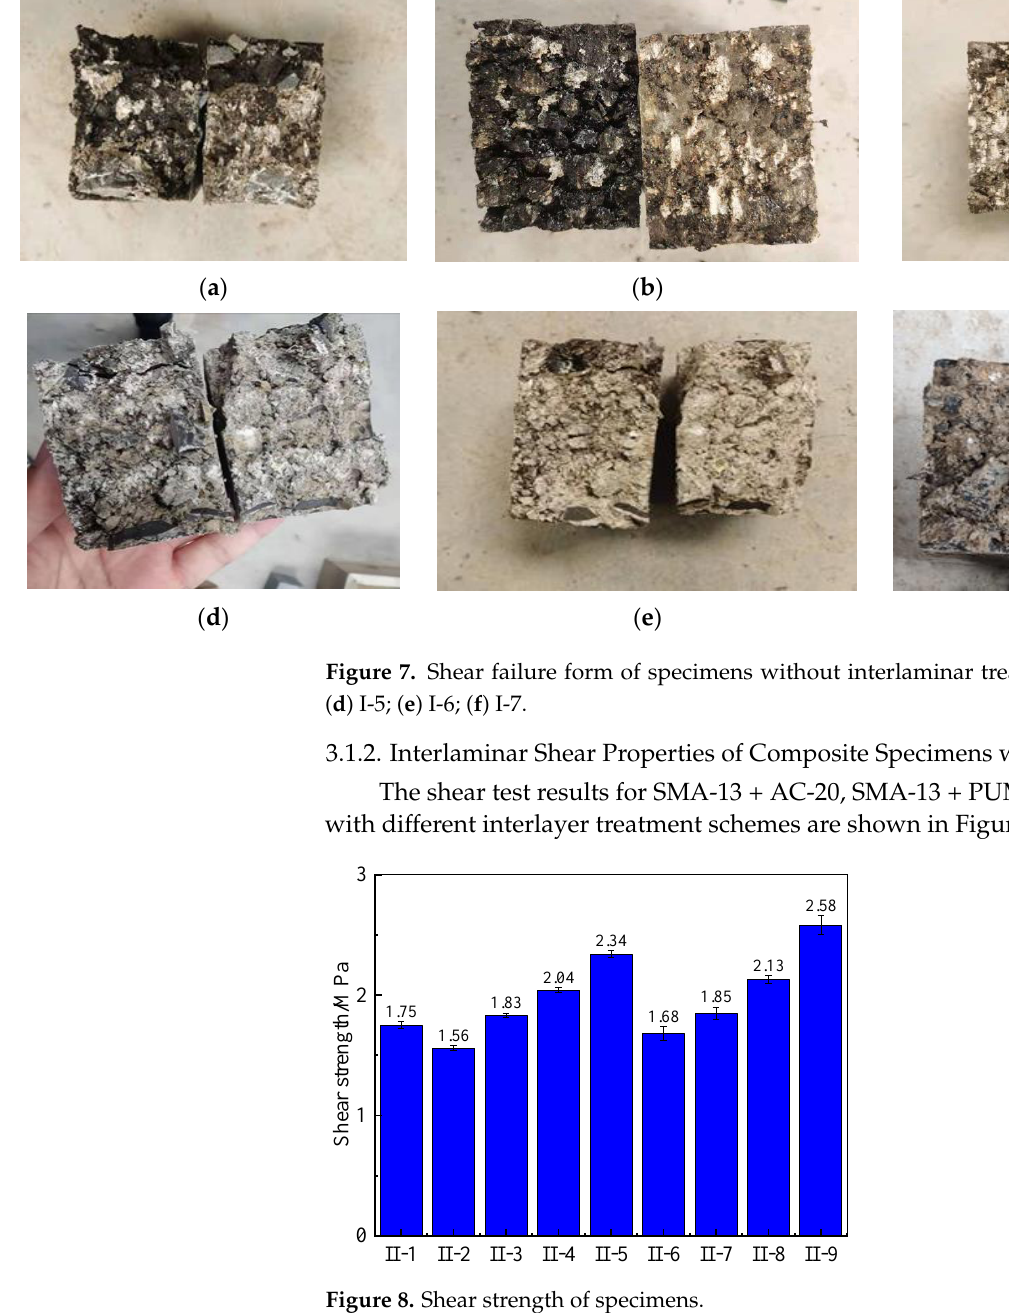
Figure 7. Shear failure form of specimens without interlaminar treatment. ( a ) I-1; ( b ) I-2; ( c ) I-3; ( d ) I-5; ( e ) I-6; ( f ) I-7.